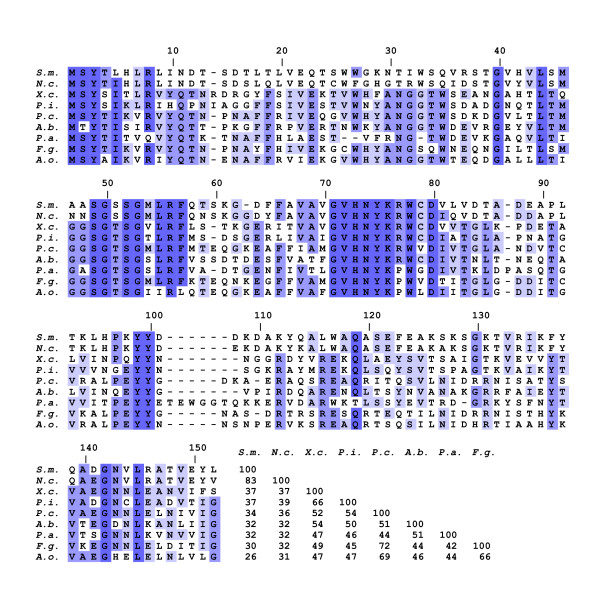
Multiple alignment of TAP1 and lectins from filamentous fungi. The multiple alignment was created using CLUSTALX [25] with the following sequences: S.m., Sordaria. macrospora TAP1 [this work, emb:CAH03681.2]; N.c., Neurospora crassa NCU05651.2 [ref:XP_325506.1]; X.c., Xerocomus chrysenteron lectin [gb:AAL73236.1]; P.i., Paxillus involutus LECA [gb:AAT91249.1]; P.c., Pleurotus cornucopiae PCL-F2 [dbj:BAB63923.1]; A.b., Agaricus bisporus ABL [sp:Q00022]; P.a., Podospora anserina Pa5D0092 [emb:CAD60779.1]; F.g., Fusarium graminearum FG07558.1 [gb:EAA76455.1]; A.o., Arthrobotrys oligospora lectin [emb:CAA65781.1]. Jalview was used to visualize the alignment [26]. Amino acid residues conserved in at least eight of the nine sequences are given in dark blue, residues conserved in at least six sequences in medium blue, and residues present in at least four sequences in light blue. At the end of the alignment, amino acid identity in % is given for all sequences in pair-wise comparisons.